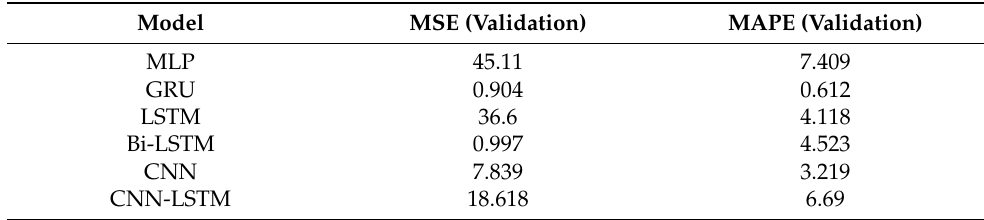
Table 15. The validation results of the models using Snapchat data with six input features.